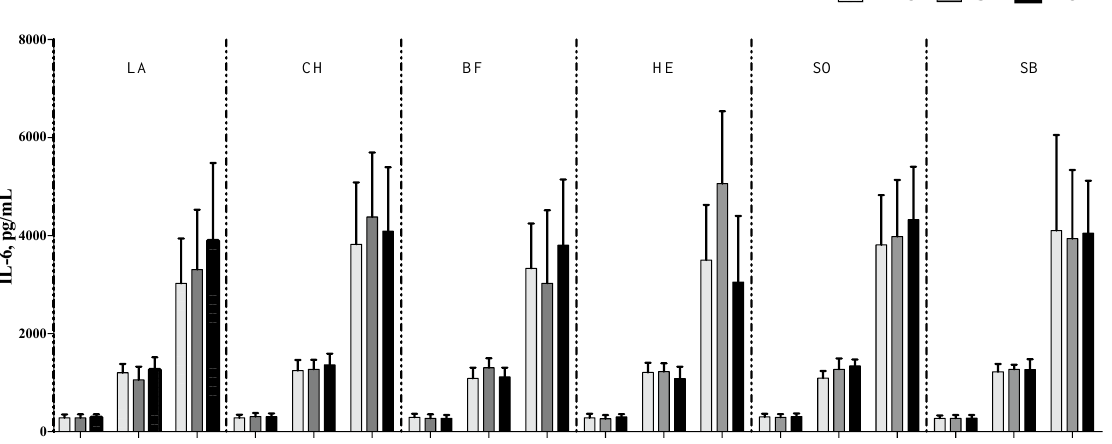
Figure 3. IL-6 secretion (means ± SE; pg/mL) in peripheral blood mononuclear cell supernatants of infants with generalized epilepsy treated in vitro with myofibrillar (MYO, light-grey bar), sarcoplasmic (SA, grey bar), and total protein (TOT, black bar) fractions from beef (BF), lamb (LA), chicken (CH), sole (SO), European hake (EH), and sea bass (SB) sources. LL-EC = group of children with epilepsy with similar levels of cytokines to those of control children; ML-EC = group of children with epilepsy with cytokine levels at least 2-fold higher (medium levels) than those of control children; HL-EC = group of children with epilepsy with cytokine levels at least 8-fold higher (high levels) than those of control children.